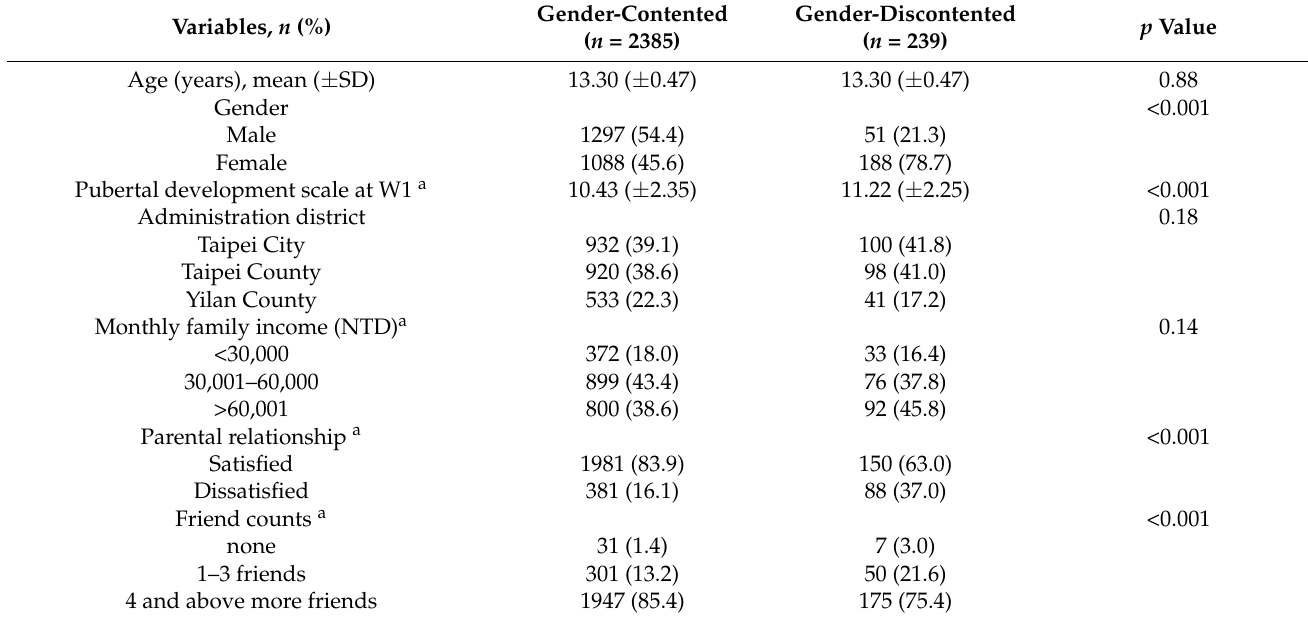
Table 1. Demographic information of participants at